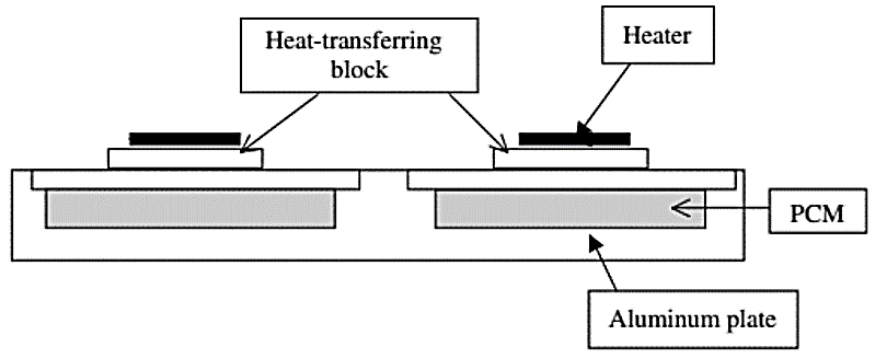
Figure 15. Heat storage unit including PCM [167].